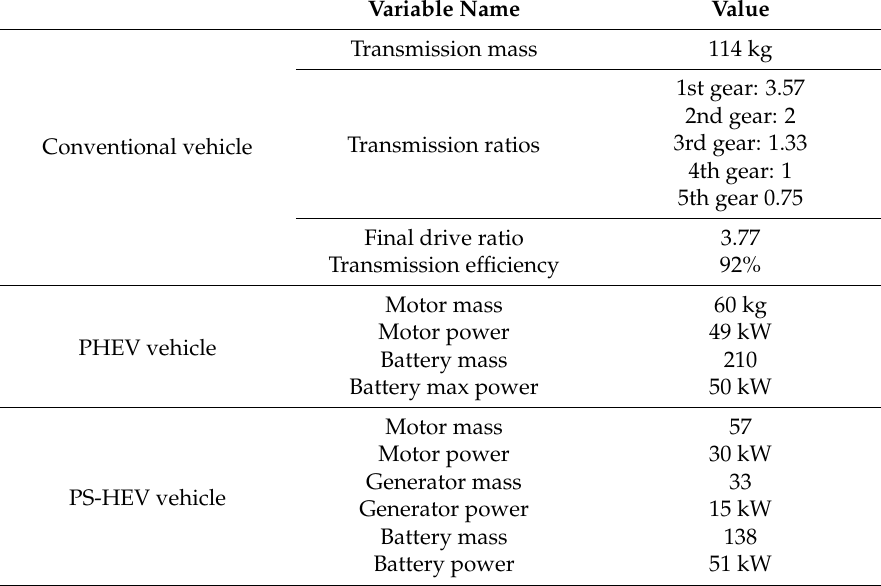
Table A1. Parameters of comparison vehicles: conventional, PHEV, and